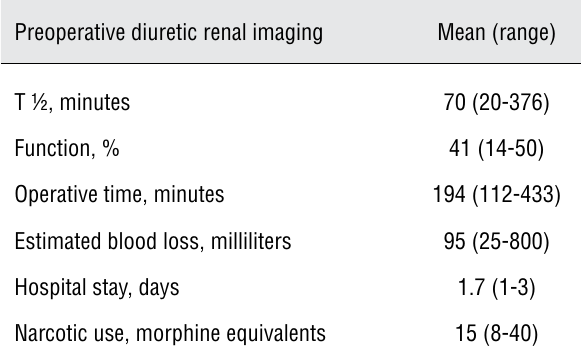
Table 2 - Perioperative statistics. Preoperative diuretic renal imaging Mean (range)